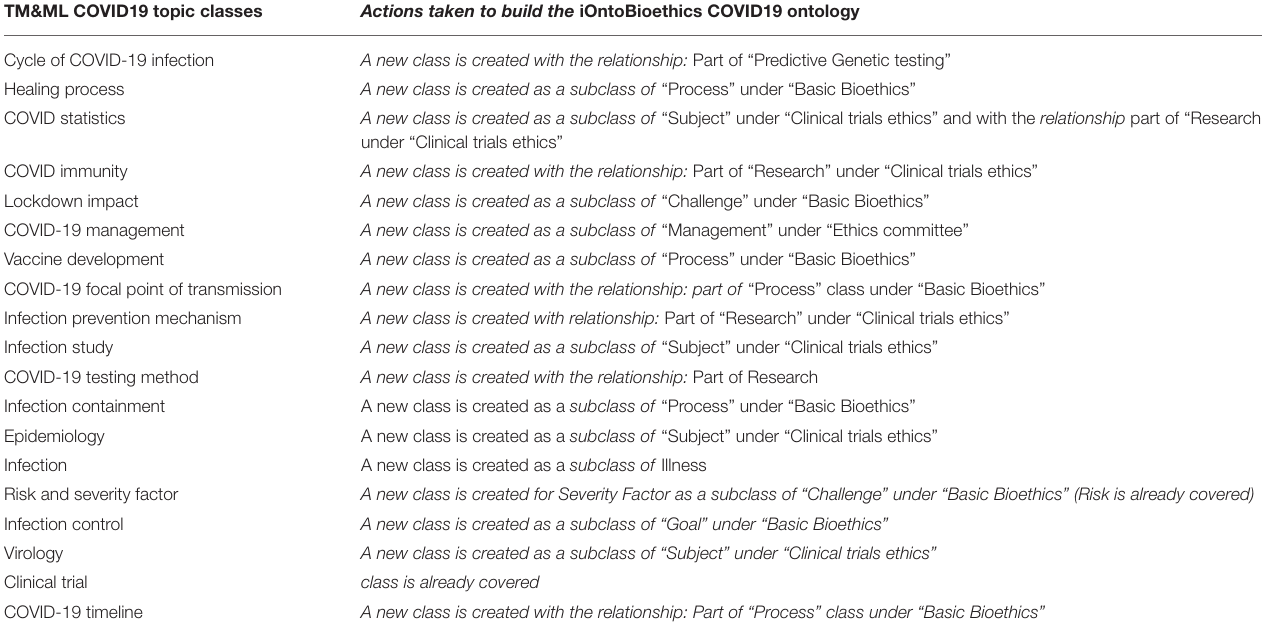
TABLE 2 | COVID-19 TM&ML topic classes extending the iOntoBioethics ontology in forming the iOntoBioethics COVID19 ontology. TM&ML COVID19 topic classes